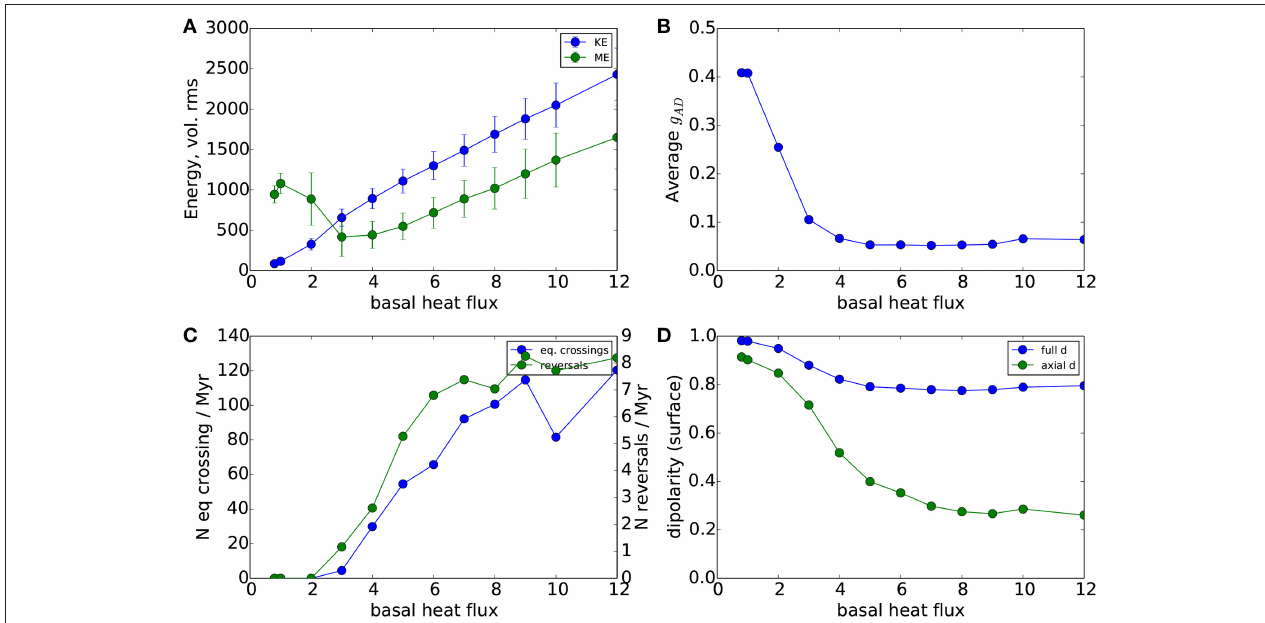
FIGURE 5 | Comparison of time average dynamo statistics. (A) Time averaged volumetric RMS kinetic (KE) and magnetic energies (ME). (B) Time averaged RMS axial Gauss coefficient g 1,0 . (C) Number of dipole axis equator crossings (left scale) and number of reversals (right scale) per Myr. (D) Time averaged dipolarity of Gauss coefficients for the full dipole g D / g RMS and the axial dipole g 1,0 / g RMS